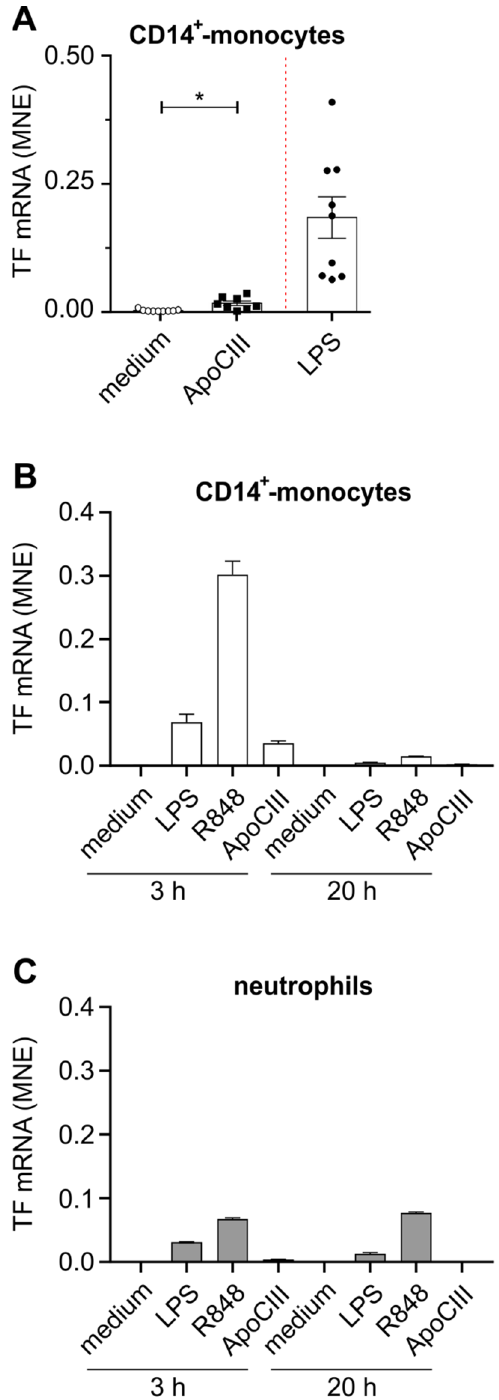
Figure 2 . Expression of tissue factor (TF) mRNA in human CD14 + -monocytes and autologous neutrophils exposed to ApoCIII. Human CD14 + -monocytes ( A , B ) and autologous neutrophils ( C ), purified as described in Section 4.2, were incubated for 3 h ( A – C ) and/or 20 h ( B , C ) in the absence (medium) or presence of 50 µg/mL ApoCIII, 100 ng/mL LPS ( A , B ), 1 µg/mL LPS ( C ) or 5 µM R848 ( B , C ). Total RNA was then extracted and examined for TF mRNA expression by quantitative RT-qPCR. Gene expression is depicted as MNE units after normalization to GAPDH mRNA. For panel A , data are represented as mean ± SEM, n = 8–9, and were analyzed by unpaired t-test with Welch correction. * p < 0.05. Panels B and C show a representative experiment from a single donor (out of 2 performed with similar results). Data are represented as mean ± SEM of experimental replicates.